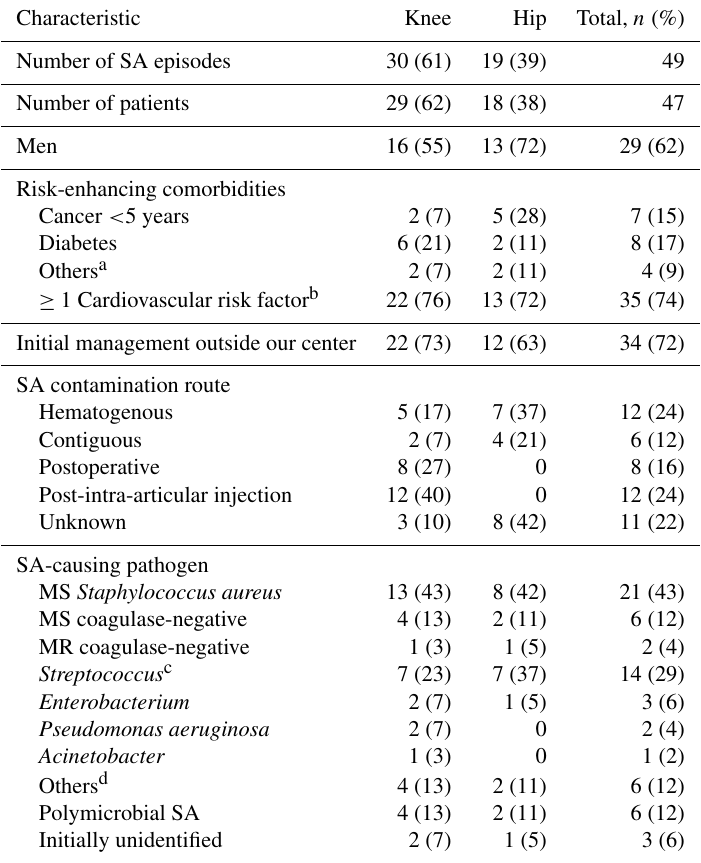
Table 1. Epidemiological and microbiological characteristics of the 47 patients and 49 SA episodes, according to the affected joint.